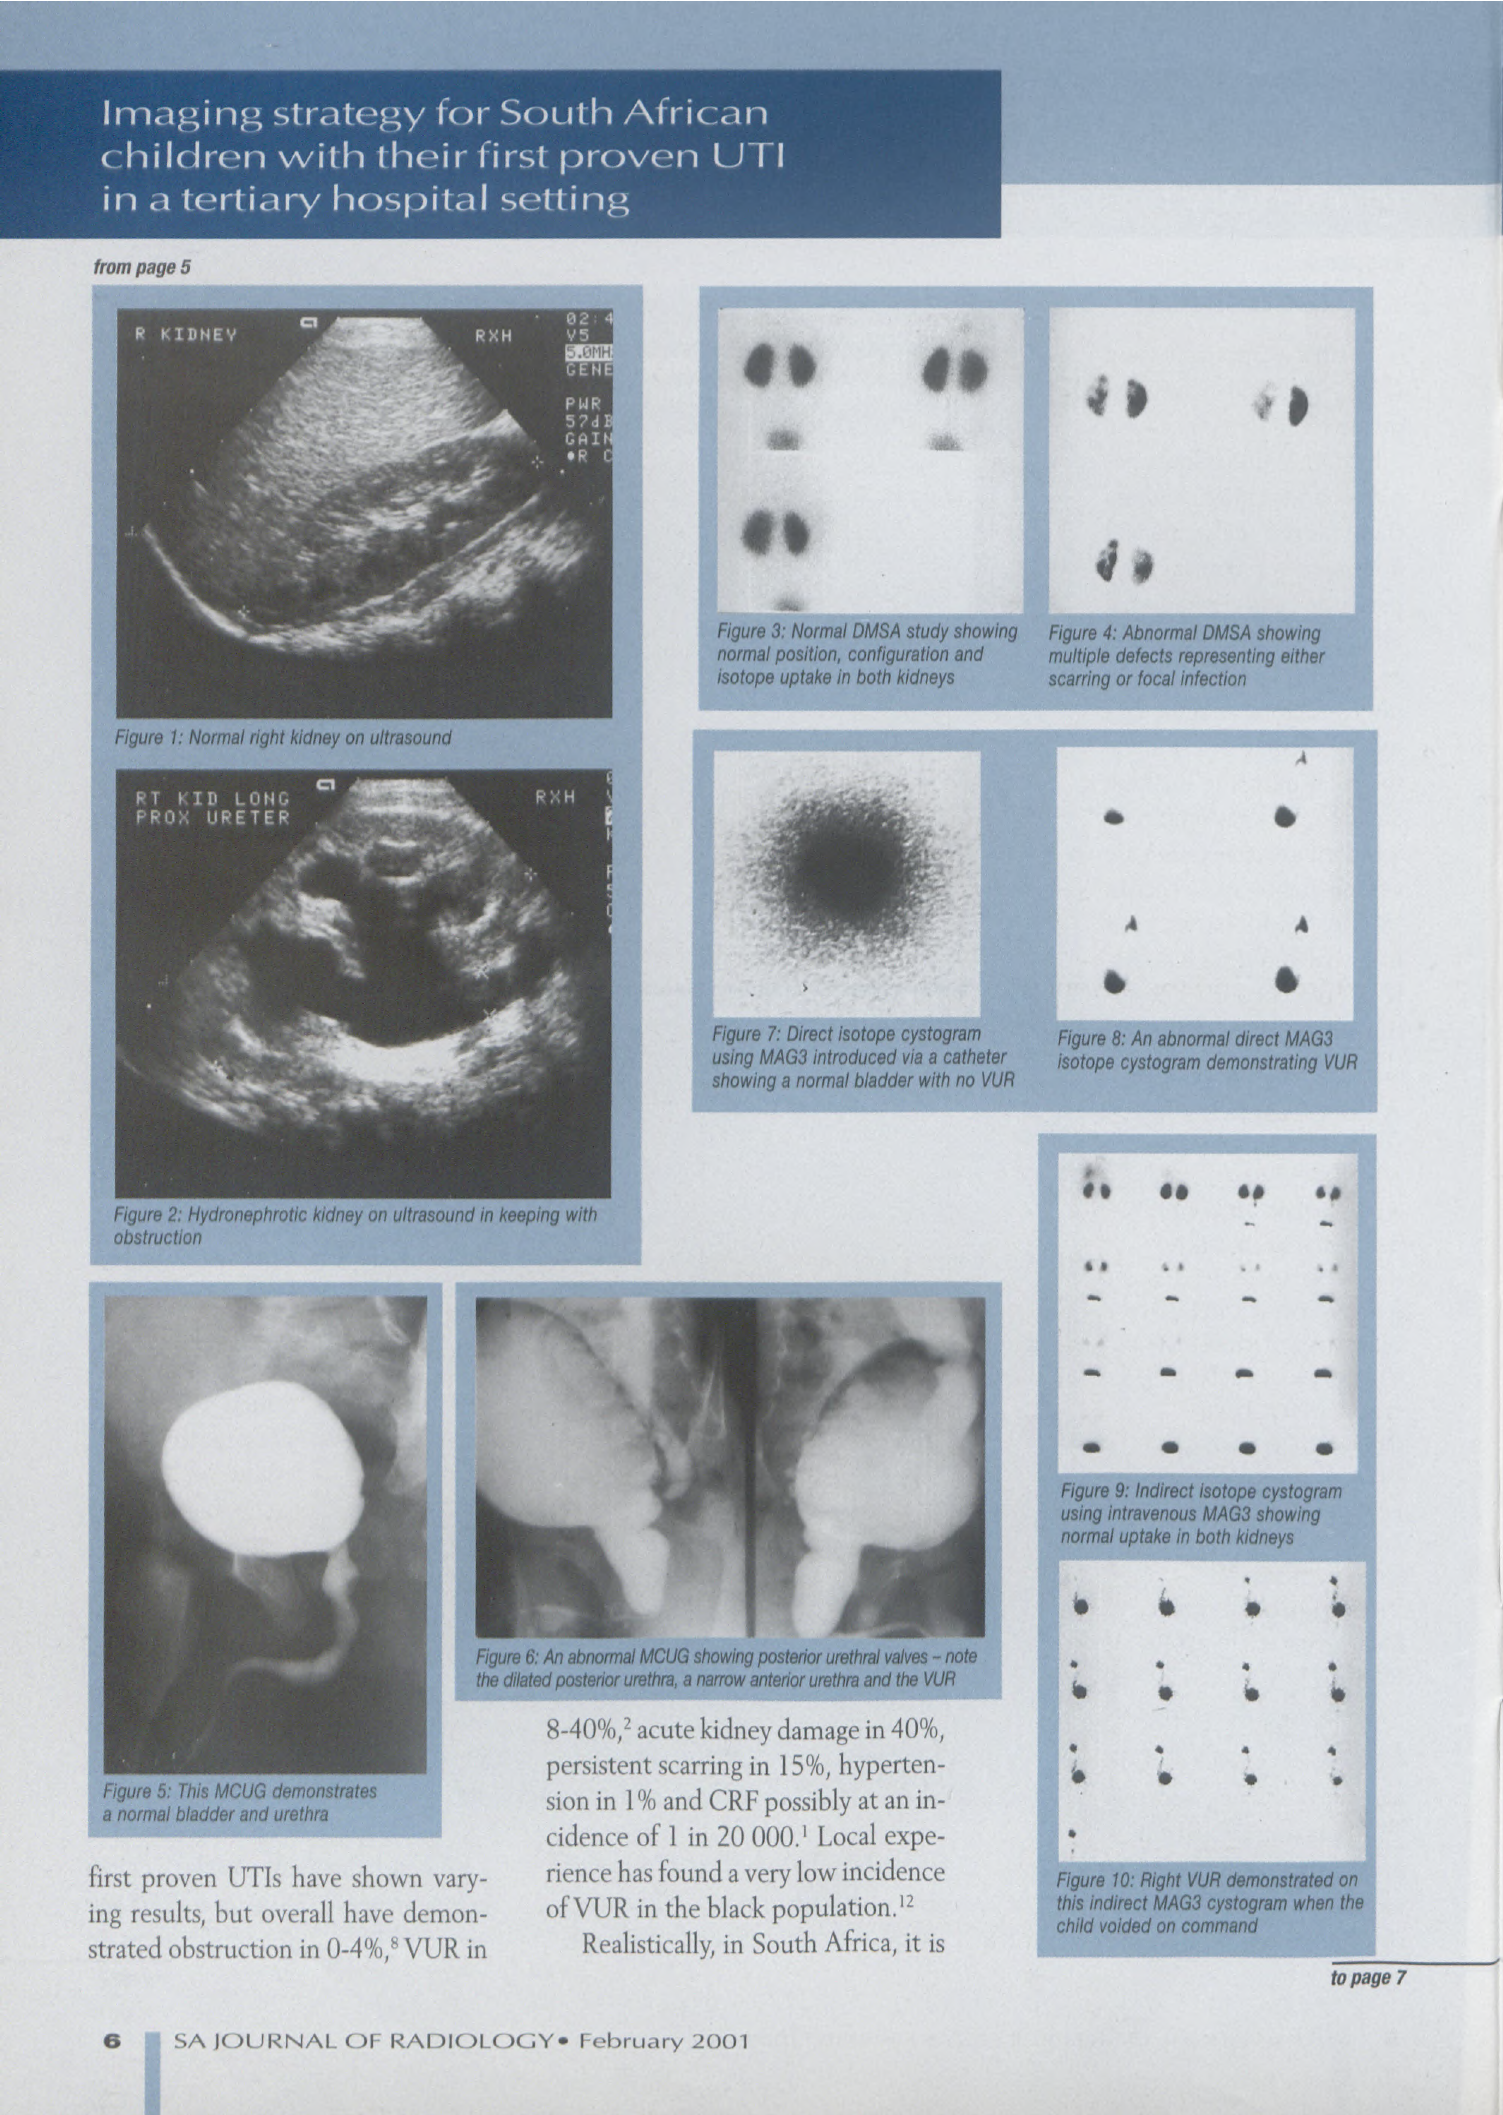
Figure 3: Normal DMSA study showing normal position, configuration and Isotope uptake in both kidneys